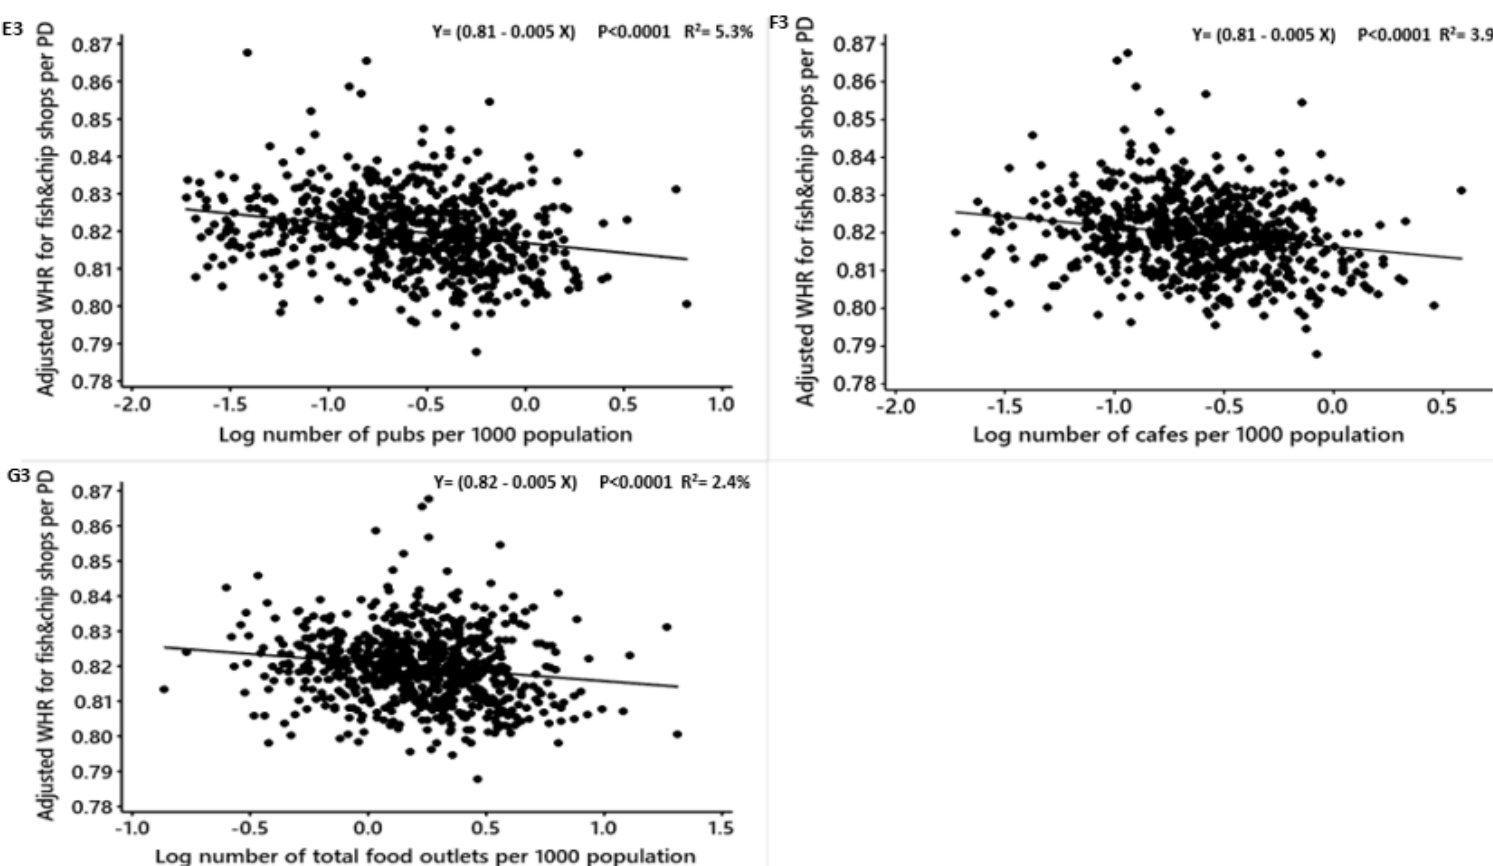
Figure 6. Females: Linear regression analysis of the association between log-transformed numbers of food outlets per 1000 population and adjusted obesity measures. Obesity measures adjusted for deprivation level per household, education, employment, ethnicity, household size, household income, age and density of fish and chip shops. BMI = Body Mass Index, WHR = Waist to Hip